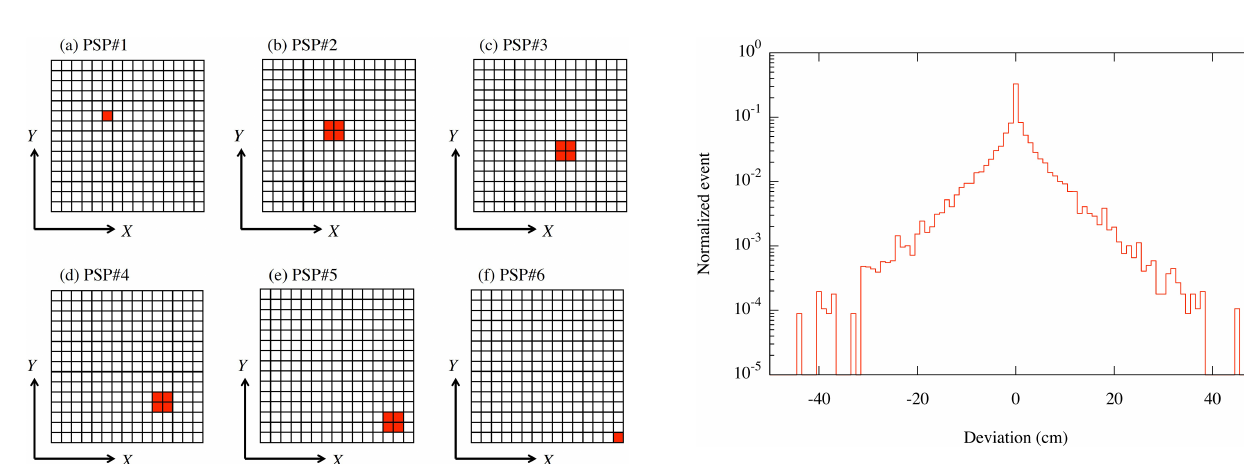
Figure 9. Example of muon tracking for N = 1. If a signal (a red square) is generated at (x,y) = ( 5 , 10 ) in PSP#1 (a) and at (x,y) = ( 15 , 1 ) in PSP#6 (f) simultaneously, the signal generation points (red squares) in PSPs #2–5 (b–e) are used for tracking.